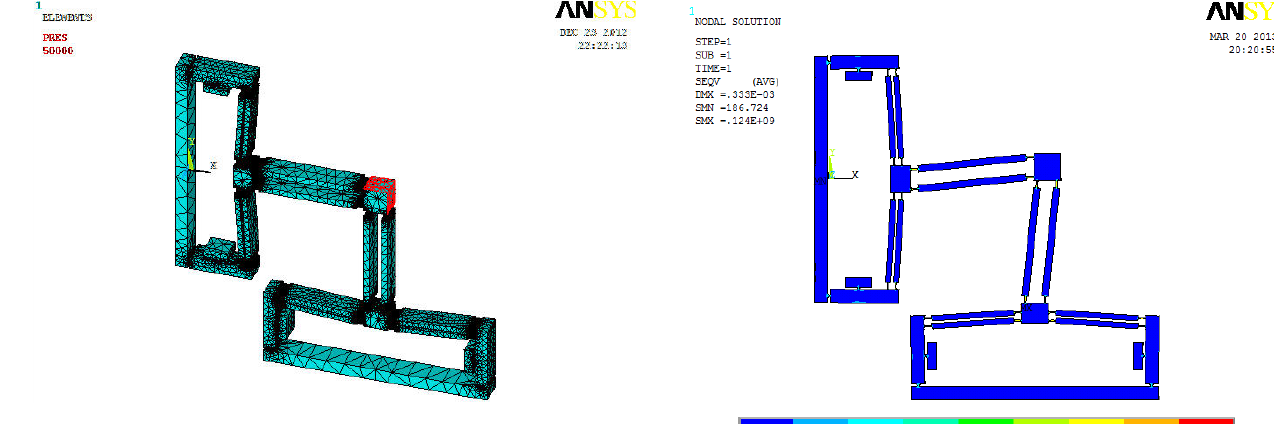
Figure 3. FEM model of the planar motion generator CMDA with the locations of the applied forces shown in red. Table 3. Initial dynamic and static analysis results.